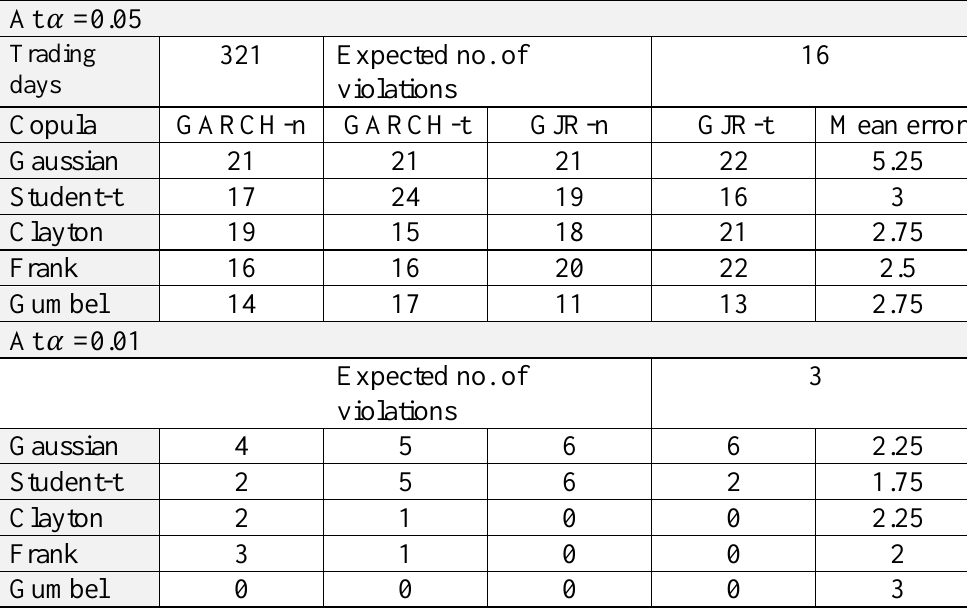
Table 5. Number of violations of the VaR estimation.